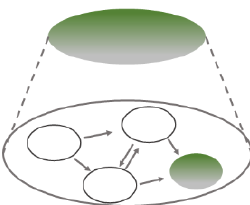
Figure 3. Production within an underlying mechanism. Please note that any component of the underlying mechanism shown in white may itself also be an explananda of another, even deeper underlying mechanism.